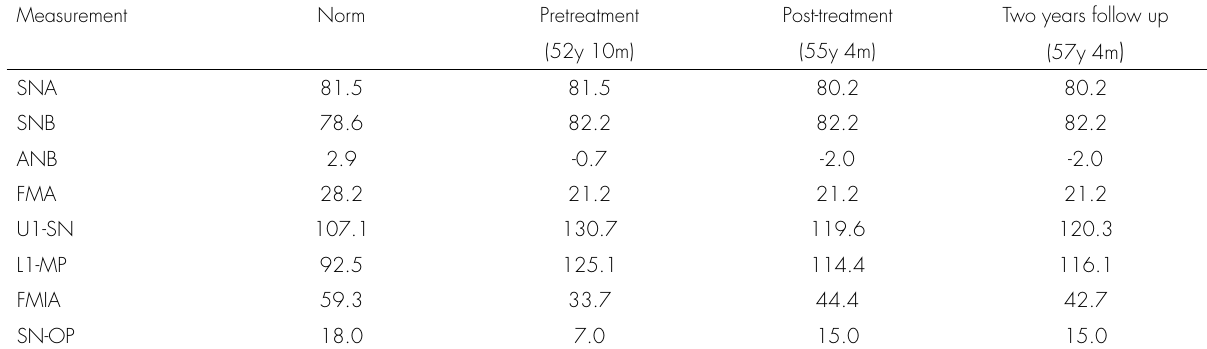
Table I. Summary of cephalometric